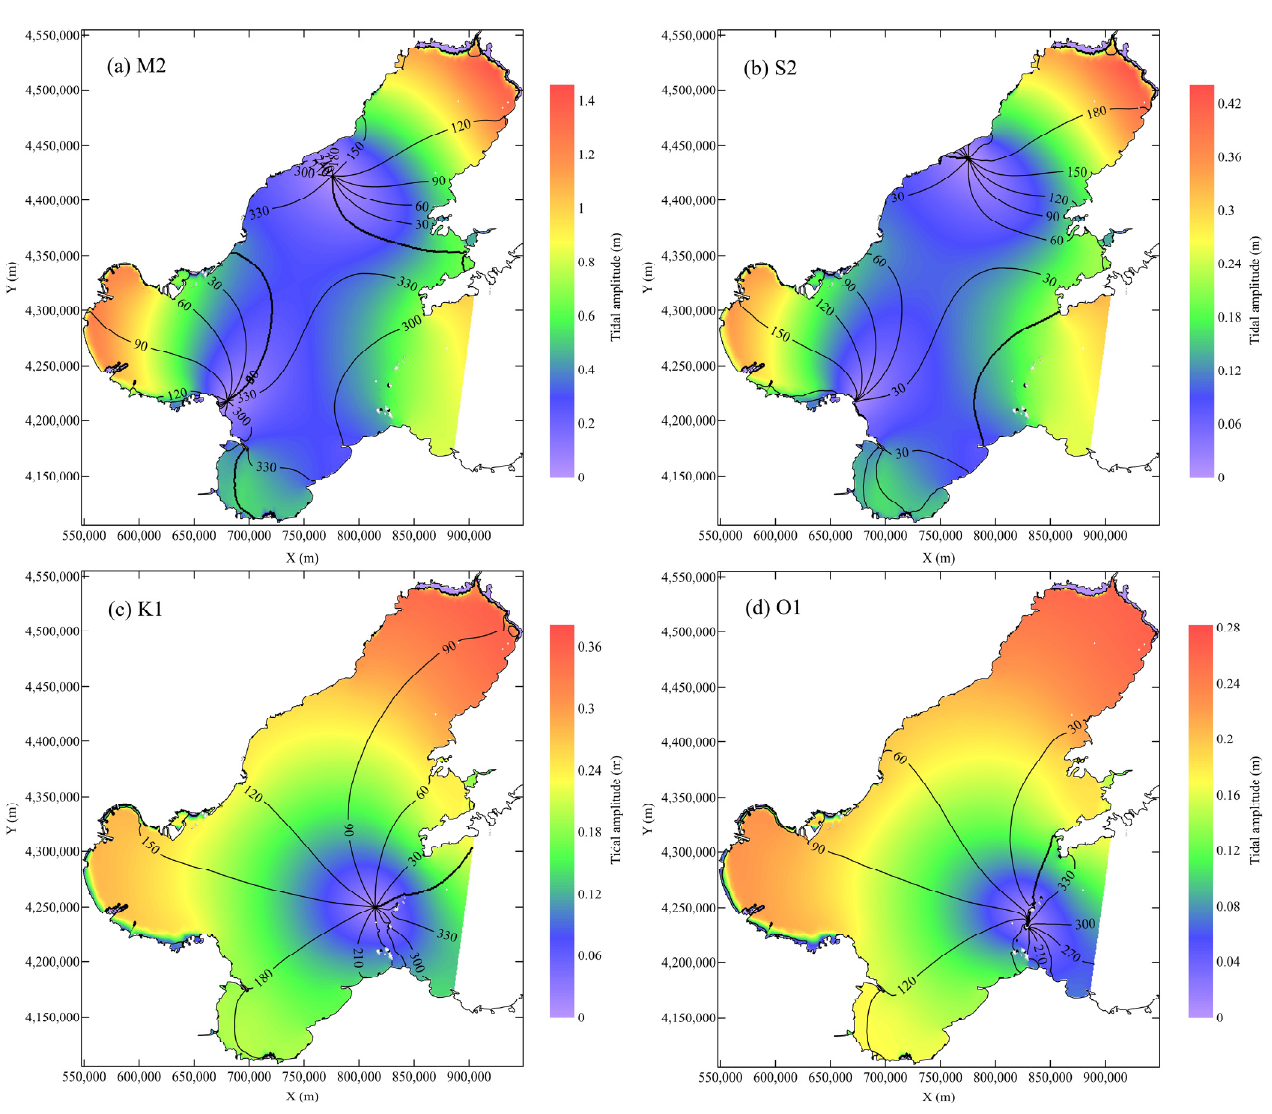
Figure 6. Cotidal charts of ( a ) M2; ( b ) S2; ( c ) K1; and ( d ) O1 in the Bohai Sea. The black lines represent the phase lag, and the color-filled contour maps represent the amplitude of the four tidal constituents.